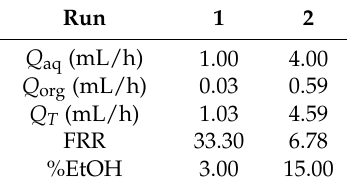
Table 1. Two independent runs were done with different flow rates and flow rate